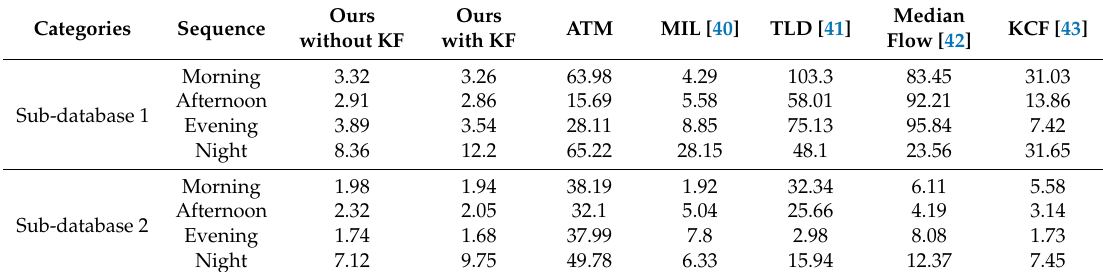
Table 3. Comparisons of average CLE obtained our method with those obtained by other methods (pixels).